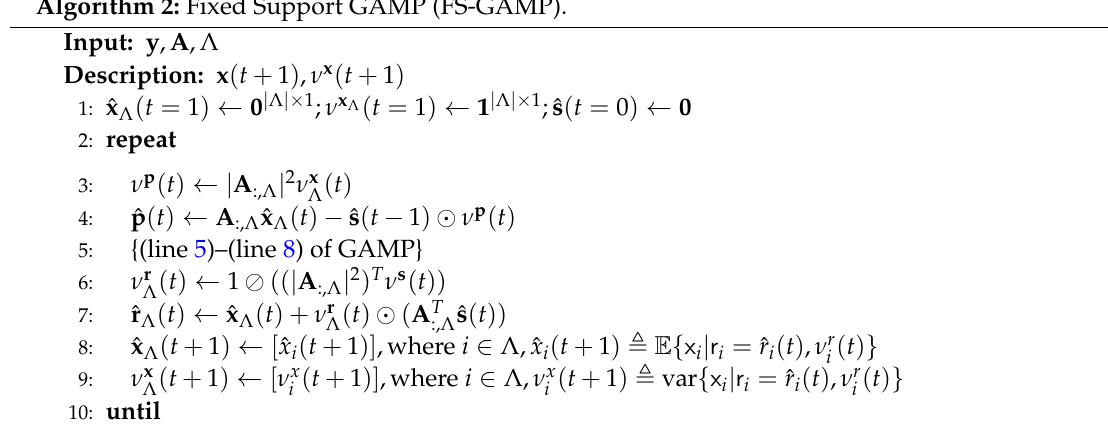
Algorithm 2: Fixed Support GAMP